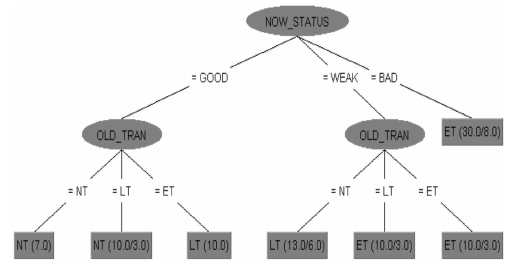
Figure 8. The decision tree obtained from the experiment Fig. 7. The decision tree obtained from the experiment Implementation of delay-transmission mechanism. Signal